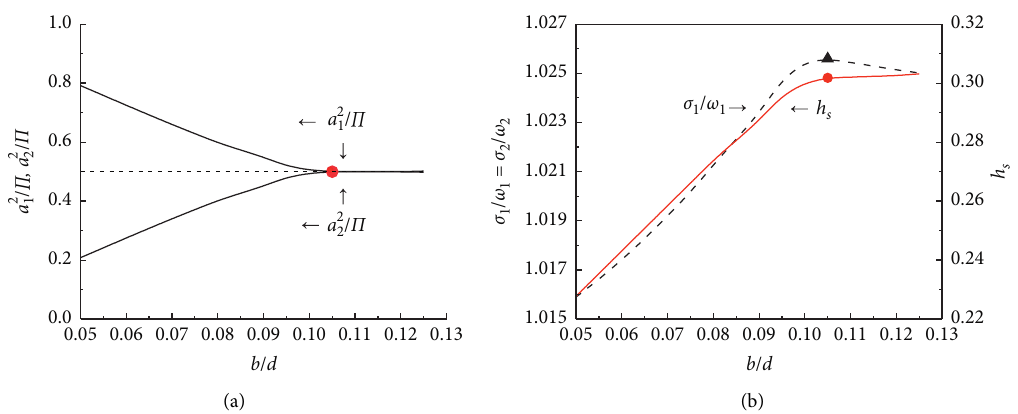
Figure 3: Wave energy distribution ( a 2 of the class-I Bragg exact resonant wave system in the case of k Type 1 and 2. (b) Angular frequency and wave steepness in Type 2.